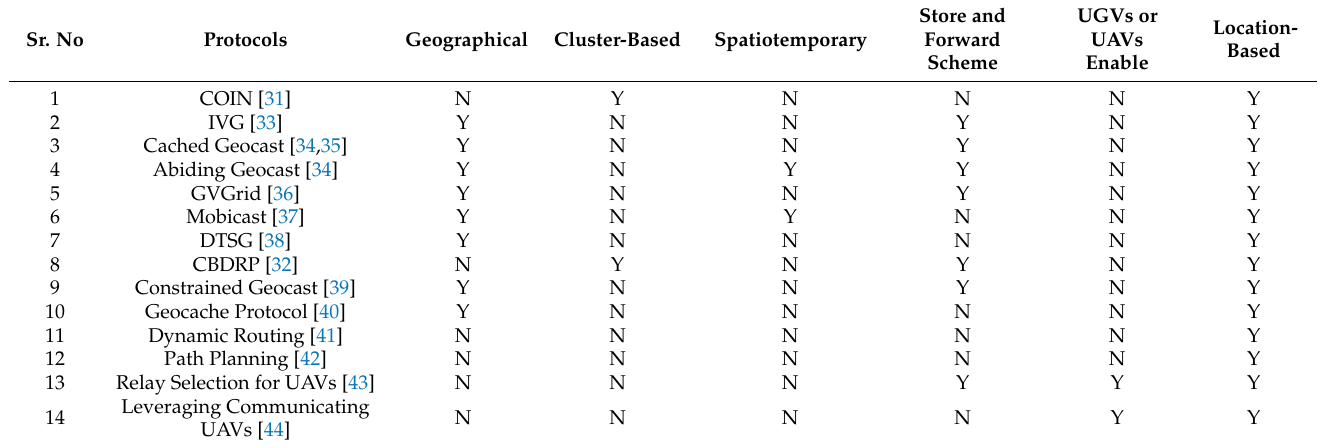
Table 1. Comparison Summary of Existing Routing